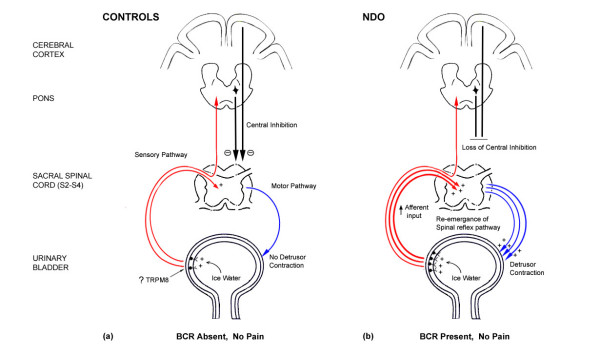
Mechanisms of the BCR in control and neurogenic (NDO) bladders. Diagram of proposed mechanisms of the bladder cooling reflex and pain in patient sub-groups during the ice water test (IWT). In neurologically normal adults and older children (> 4 years), the segmental spinal reflex pathway is normally inhibited by descending signals from higher centres (a). There is loss of central inhibition and increased afferent activation in neurogenic detrusor overactivity (NDO) patients (b), resulting in a positive IWT.